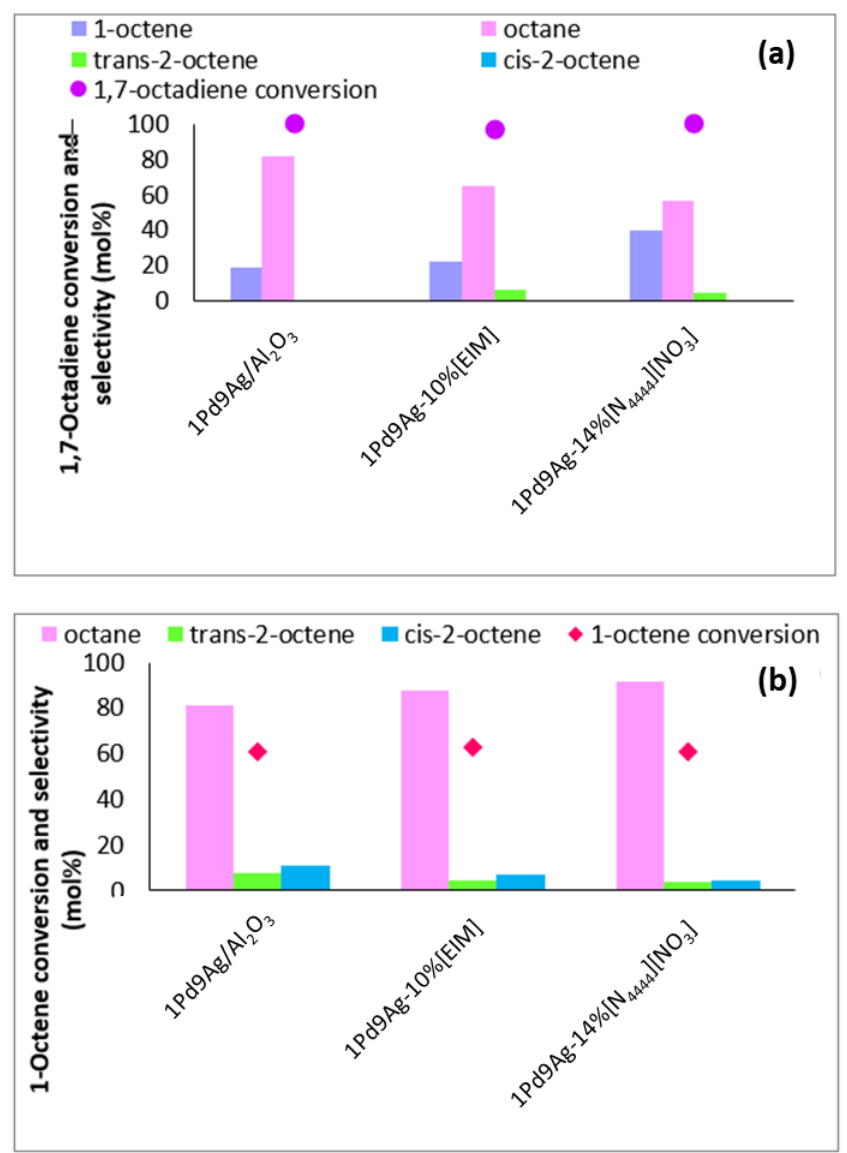
Figure 6. Non-competitive hydrogenation studies using ( a ) 1,7-octadiene and ( b ) 1-octene in hexane over 1Pd9Ag/Al 2 O 3 and 1Pd9Ag-14%[N 4444 ][NO 3 ]. Reaction conditions: Pressure: 30 bar, Diene:H 2 ratio: 1:3.5, Temperature: 100 °C. The standard deviation for values at 6 h is ± 0.2 mol%.